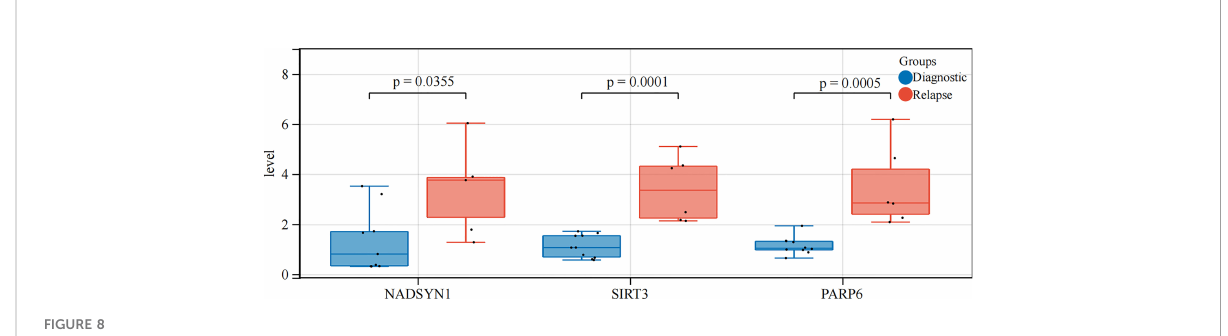
FIGURE 8 qRT-PCR analysis. The expression levels of NADSYN1, PARP6,